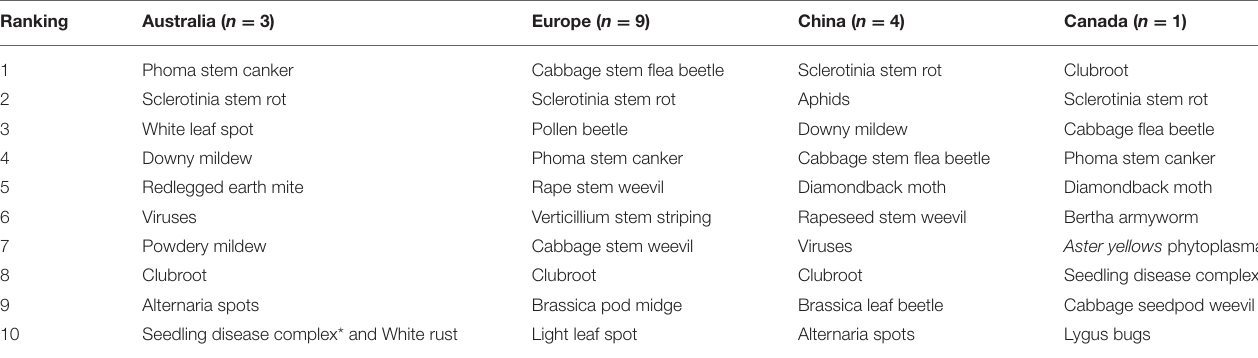
TABLE 2 | Top 10 most significant biotic threats to oilseed rape cultivation in Australia, Europe, China, and Canada at present (based on statements by 21 experts from 9 countries; n , number of statements).